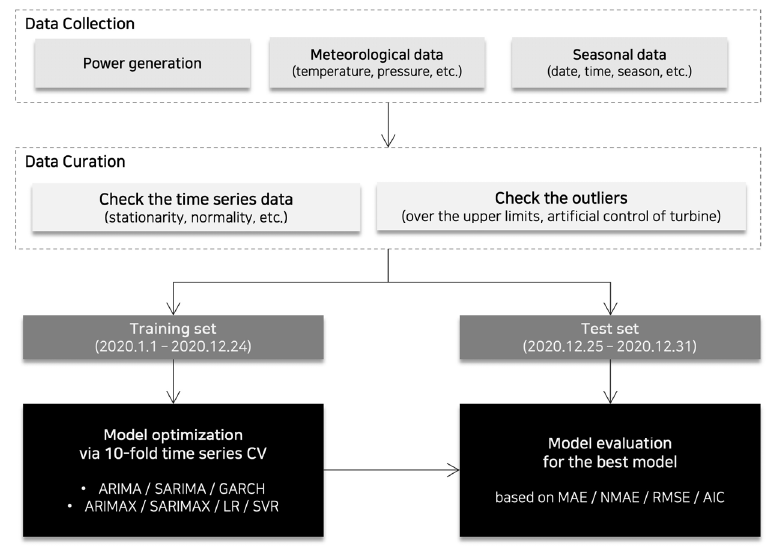
Figure 2. Process flow of data analysis.